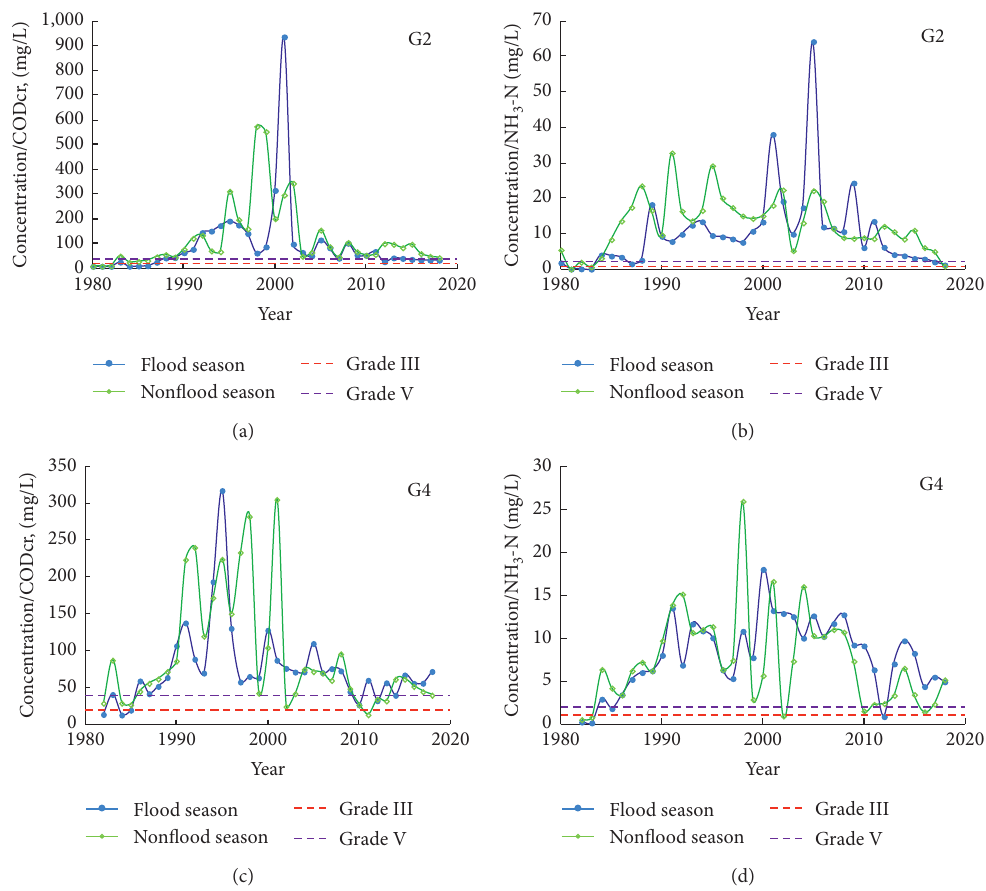
Figure 2: Trend of the temporal variations of (a) COD Cr at site G2, (b) NH 3 –N at site G2, (c) COD Cr at site G4, and (d) NH 3 –N at site G4.